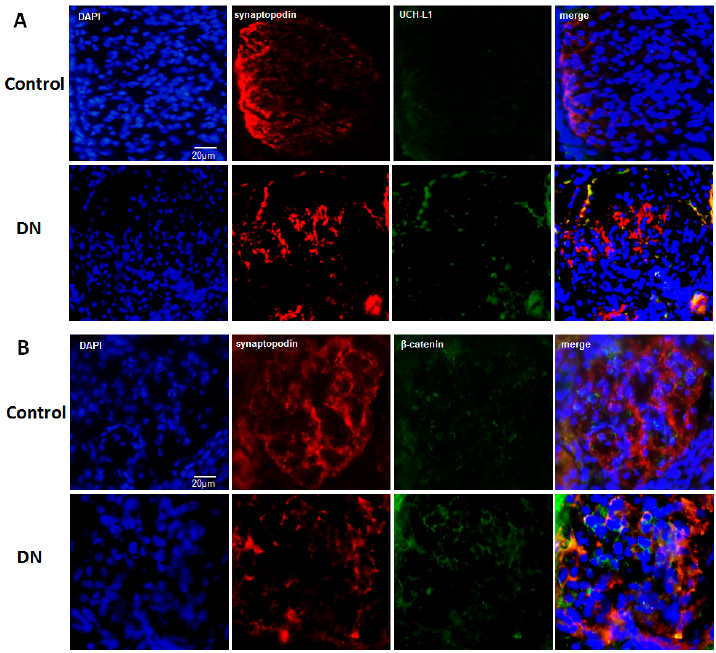
Figure 4. ( A ) UCH-L1 expression in podocytes of diabetic nephropathy patients. Immunofluorescence staining was performed in 4- μ m-thick frozen sections from healthy control persons and DN patients. Synaptopodin showed in red, UCH-L1 showed in green and DAPI showed in blue ( n = 6). Original magnification, ×200; ( B ) β -catenin expression in podocytes of diabetic nephropathy patients. Immunofluorescence staining was performed in 4- μ m-thick frozen sections from healthy controls persons and DN patients. Synaptopodin showed in red, β -catenin showed in green and DAPI showed in blue ( n = 6). Original magnification, ×200.